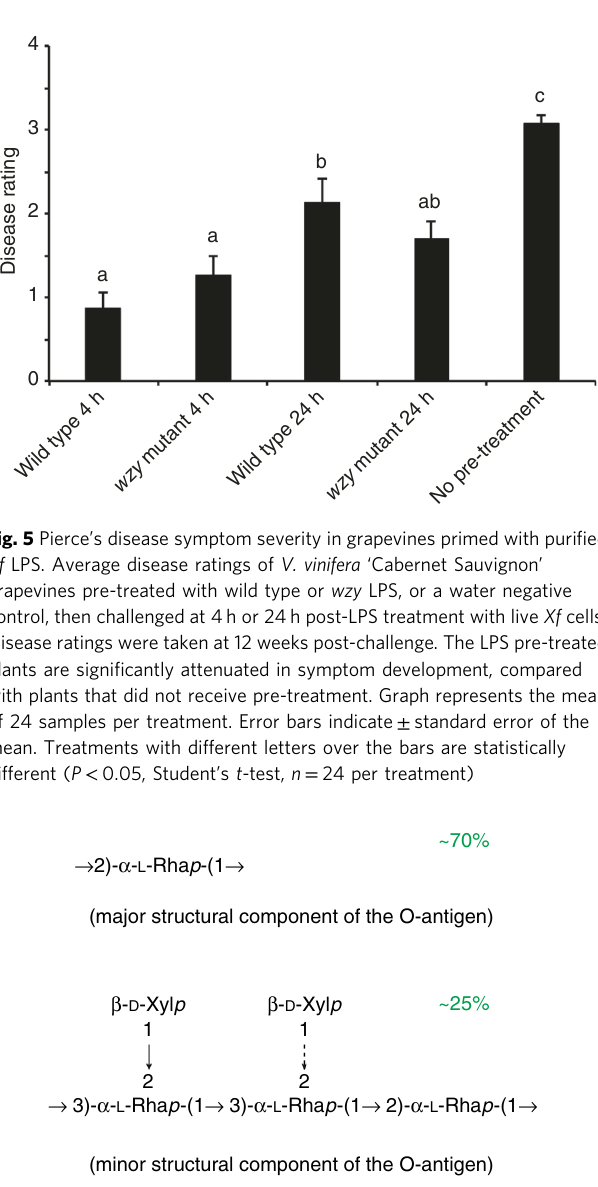
Fig. 6 Structures of Xf O-antigen. Two structural components of the O- antigen were determined. The major structure (top) consists of [ → 2)- α - L - Rha p -(1 → ] n homopolymer, and the minor structure (bottom) consists of [ → 3)- α - L -Rha p -(1 → 3)- α - L -Rha p -(1 → 2)- α - L -Rha p -( → ] n backbone substituted with either one or two β - D -Xyl p residues at C-2 of one or both of the → 3)- α - L -Rha p -(1, O-antigen, refer to Supplementary Note 2, Supplementary Note 5, Supplementary Table 1 and Supplementary Figure 6. The wzy - dependent biosynthesis of O-chain was supported by the presence of high molecular mass (HMM) bands in DOC-PAGE of wild type LPS (Supplementary Figure 5A). In contrast, the wzy mutant produced only low molecular mass LPS devoid of polymeric O- antigen, which resolved in the gel as low molecular mass (LMM) bands (Supplementary Figure 5A). This was also supported by a lack of the high molecular mass O-antigen + core OS fraction in the wzy , in size exclusion chromatography (SEC) Supplementary Figure 5B. Hence, the wzy LPS is comprised of lipid A and core oligosaccharide, whereas wild type LPS is comprised of lipid A, core oligosaccharide and full-length O-antigen. MALDI-MS analysis of Xf WT and wzy lipid A did not indicate